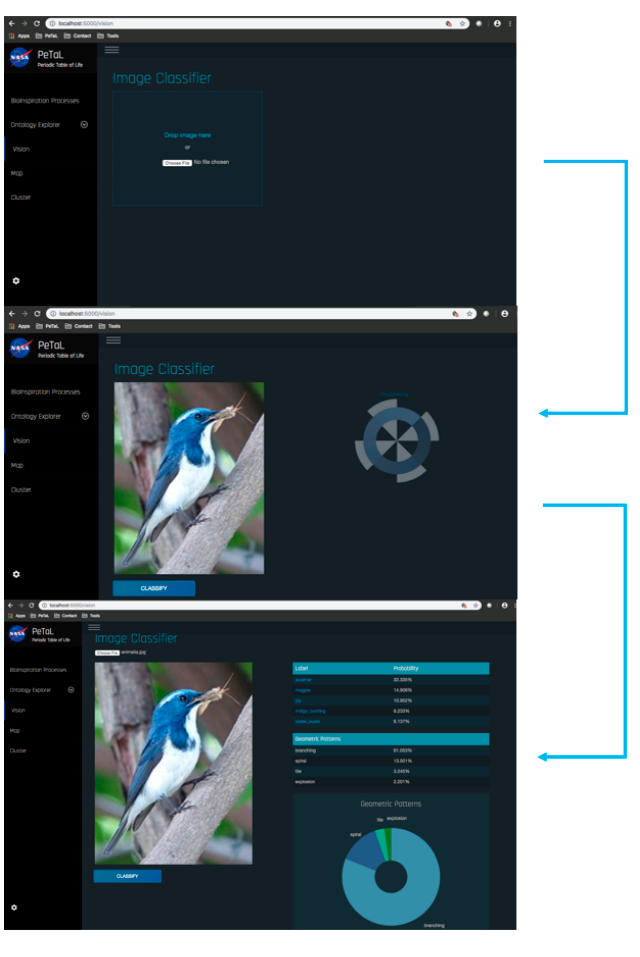
Figure 31. Topic modeling tool in PeTaL that automatically groups biological functions to form functional groupings for a bag of words approach.